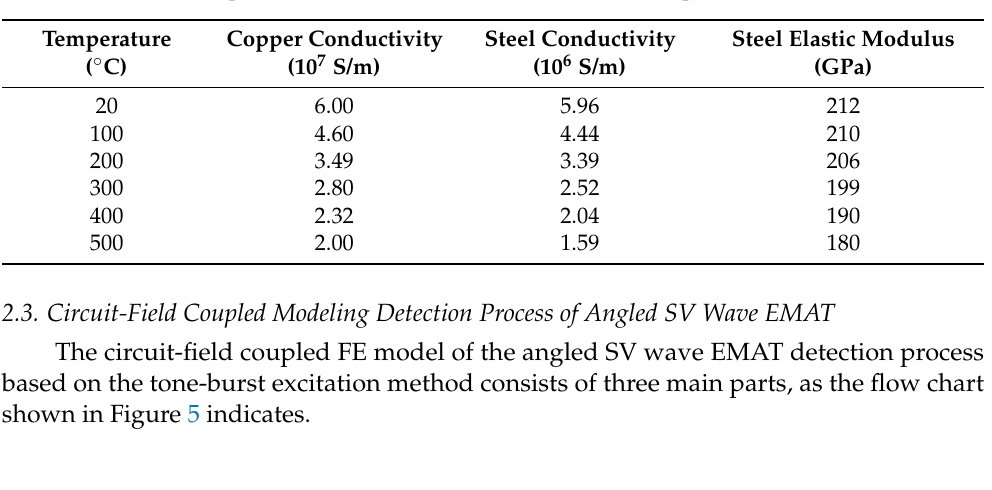
Figure 4. FE model of detection process with angled SV wave EMAT. ( a ) whole view ( b ) partial view. Table 2. Characteristic parameters of metal materials at different